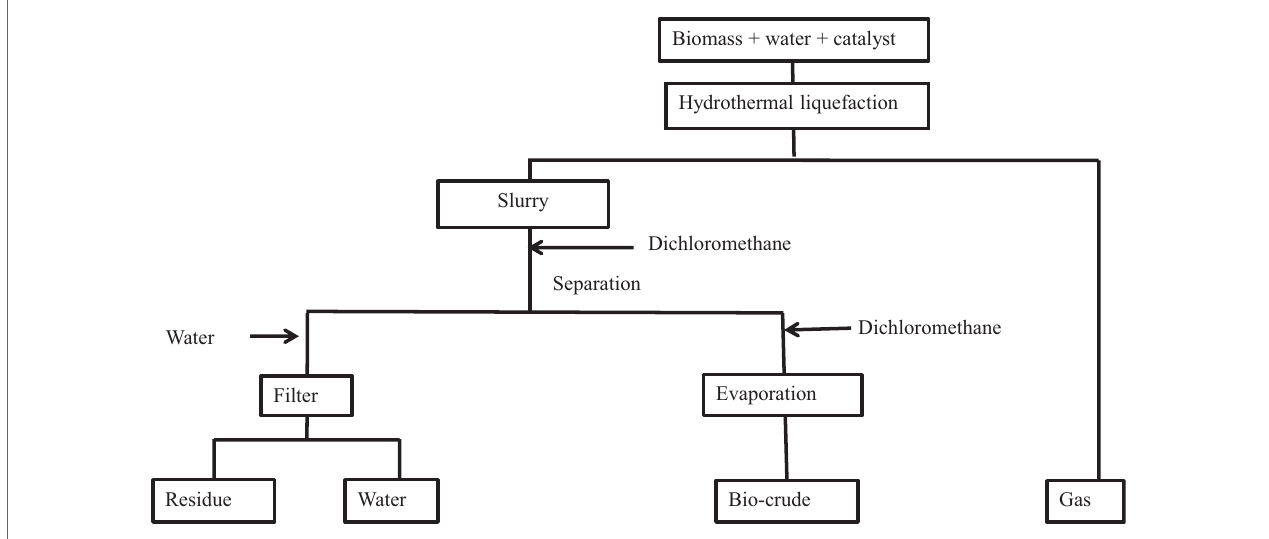
FigUre 1 | schematic of the experimental procedure for hydrothermal liquefaction of biomass